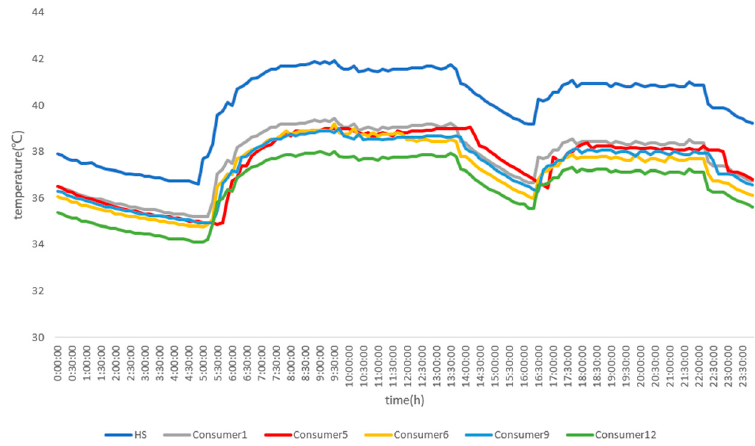
Figure 8. Hourly water supply temperature at HS and consumer.